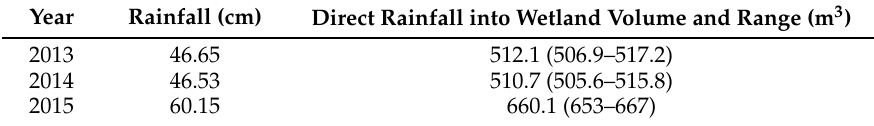
Table 5. Cumulative rainfall amounts during the monitoring period from spring thaw to late fall during the years 2013–2015. Measurements of rainfall began after the ground thawed (April) and ended when equipment was removed and temperatures were consistently below freezing, (usually November).